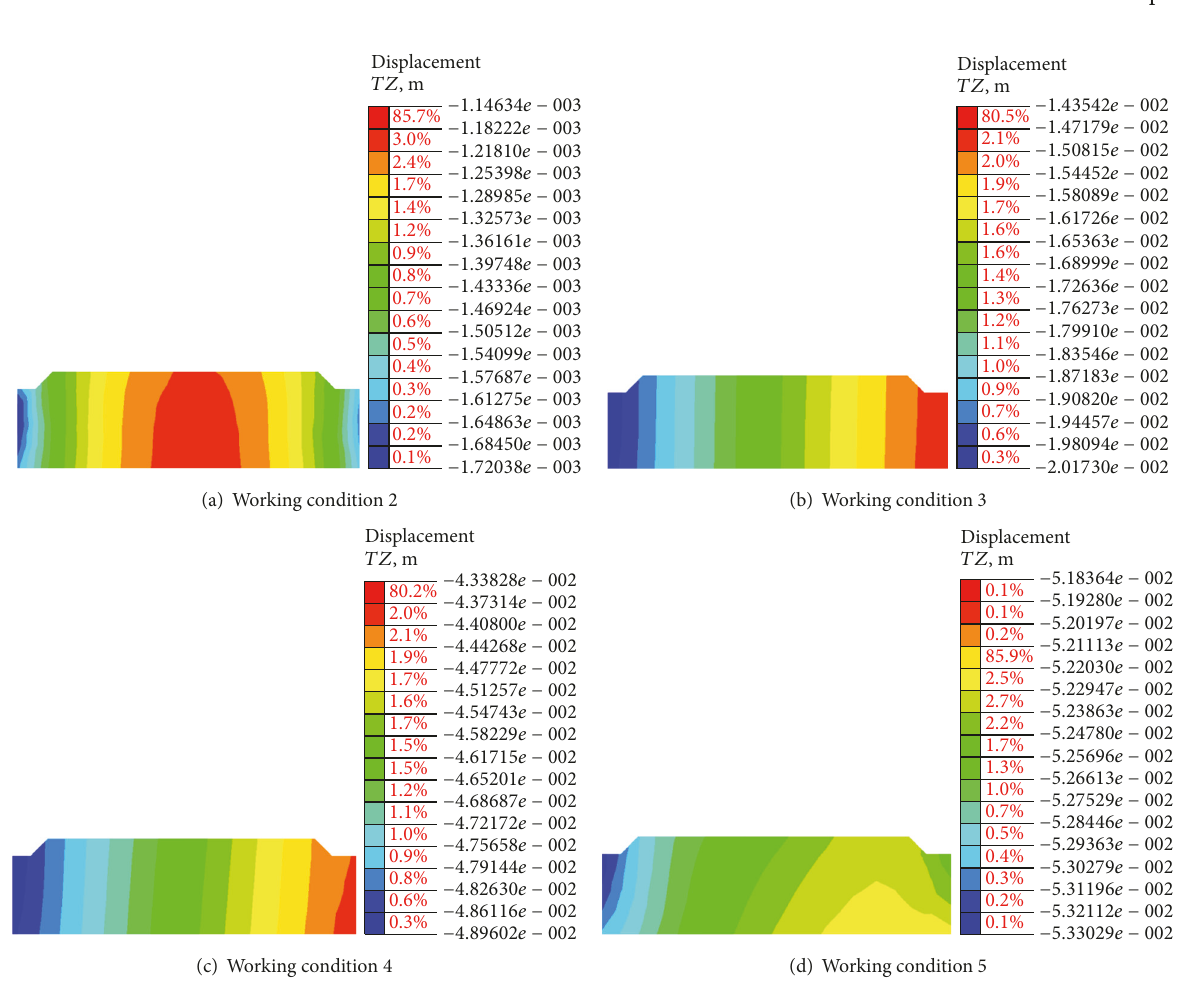
Figure 26: Vertical settlement of foundation after spinning pile